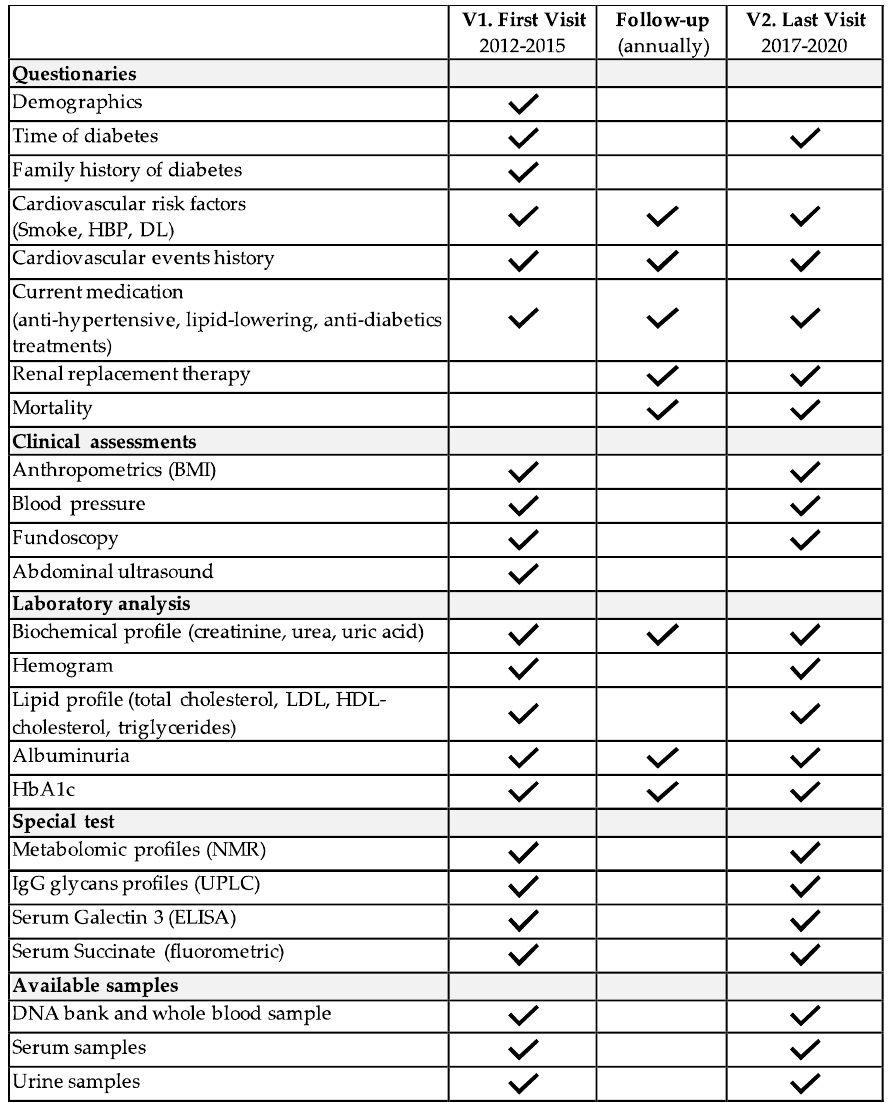
Figure 1. Summary of available data and samples from different visits and follow-ups: V1: first in-person visit; V2: last in-person visit; HBP: high blood pressure; DL: dyslipidemia; HbA1c: glyco- sylated hemoglobin; LDL: low-density lipoprotein; HDL: high-density lipoprotein; NMR: nuclear magnetic resonance spectroscopy; UPLC: ultra-performance liquid chromatography.